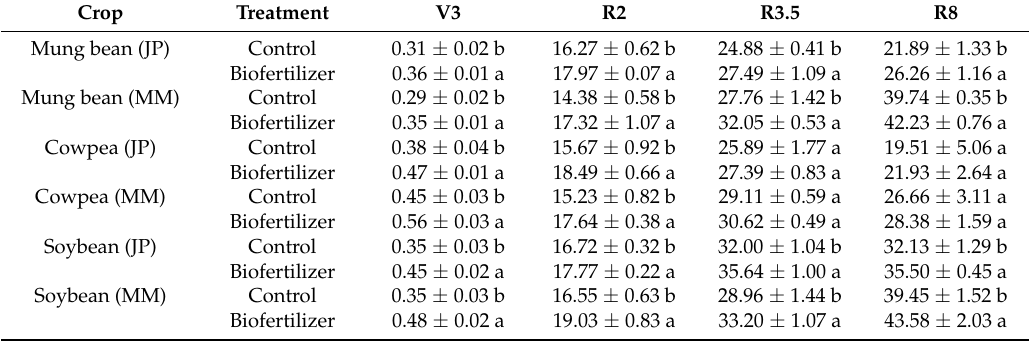
Table 4. Effect of biofertilizer on SDW (g pot − 1 ) of mung beans, cowpeas and soybeans at different growth